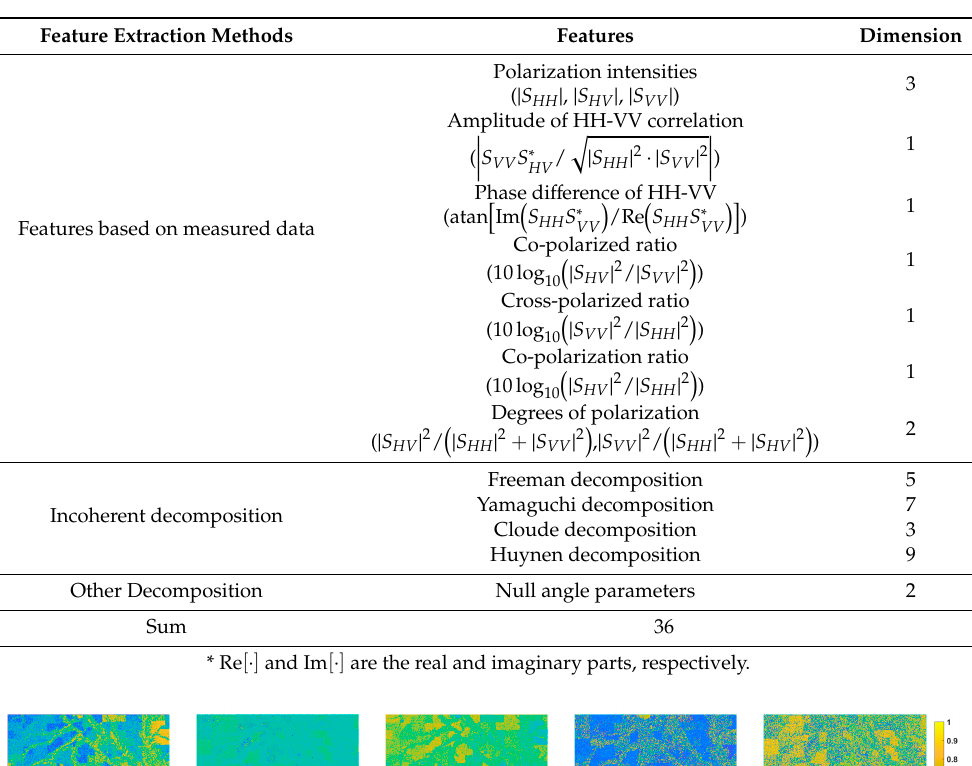
Figure 9. Classification accuracies and training time with different training ratios: ( a ) classification accuracy and ( b ) training time.